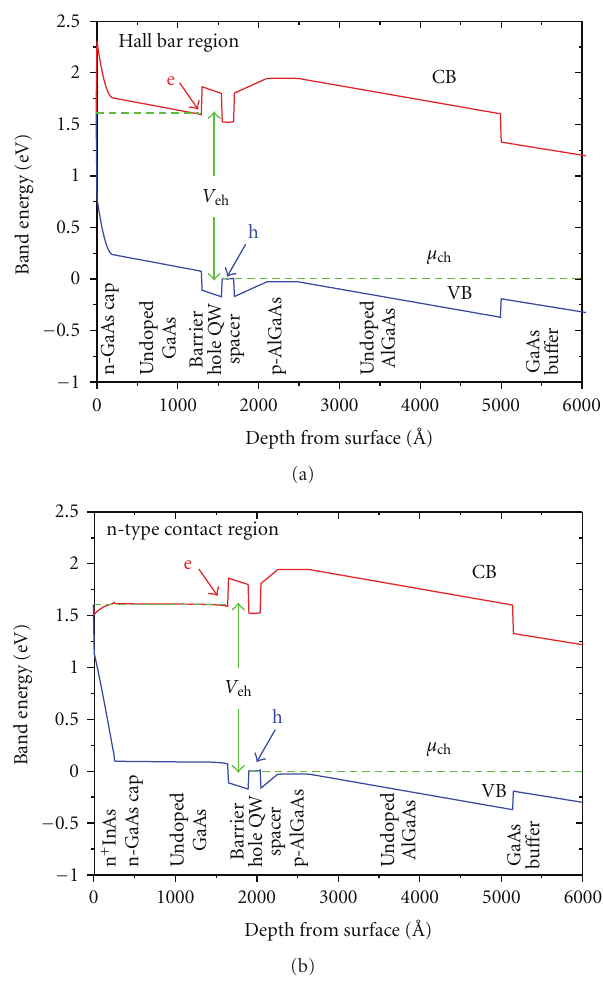
Figure 4: Self-consistent band structure calculations (a) of the Hall- bar region and (b) the n-type contact region of the device developed in the authors’ group.